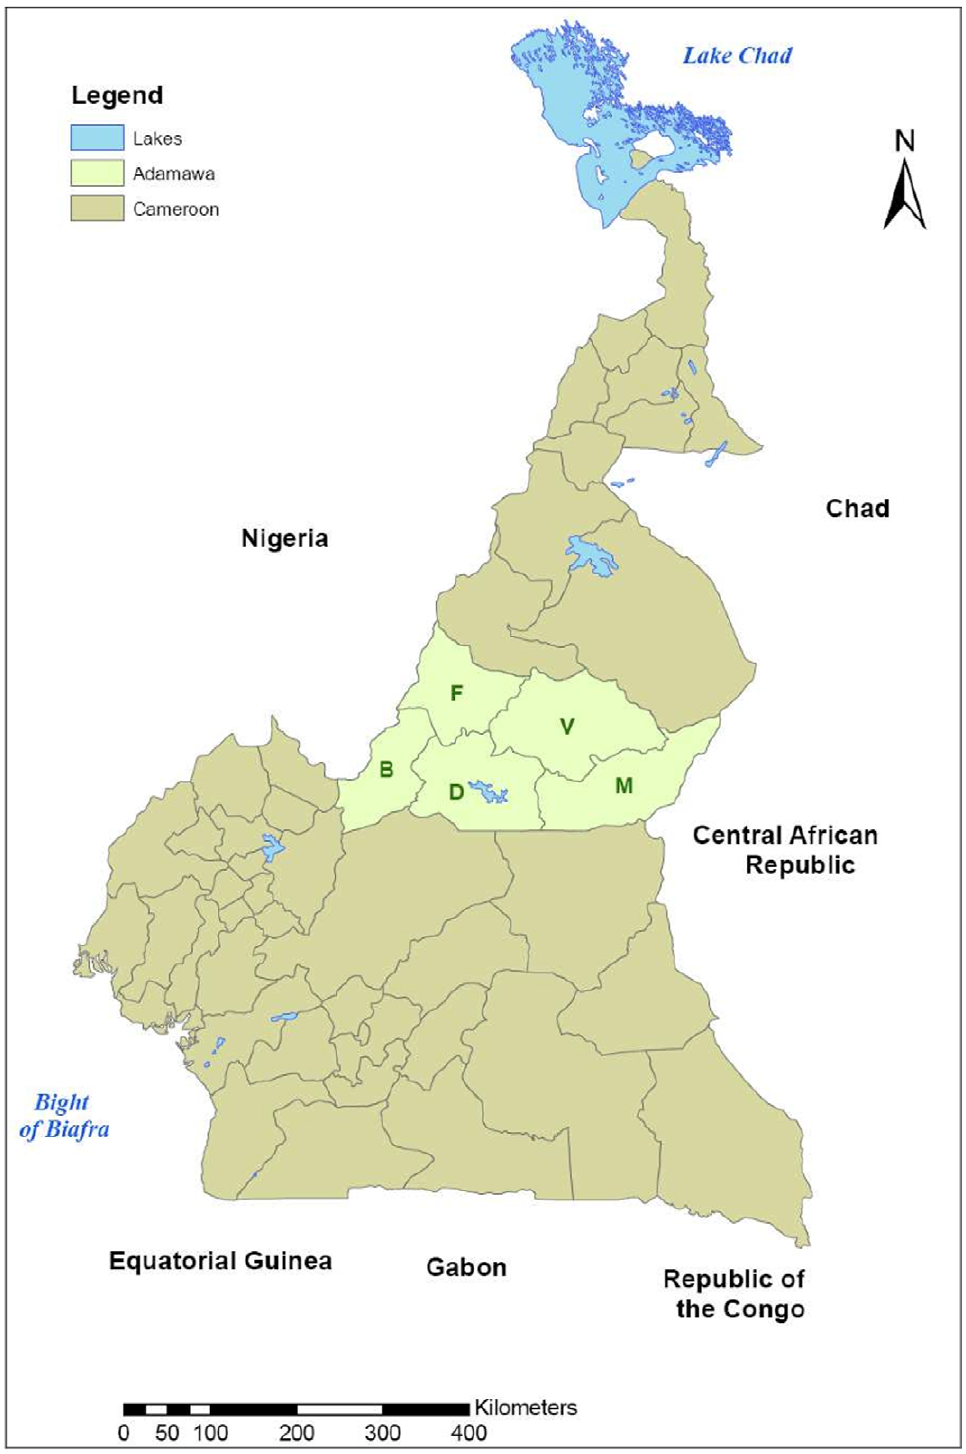
Figure 1. Political map of Cameroon showing the Adamawa Region and the five administrative Regions within it. (V=Vina; M=Mbere; D=Djerem; B=Mayo Banyo; F=Faro et Deo).